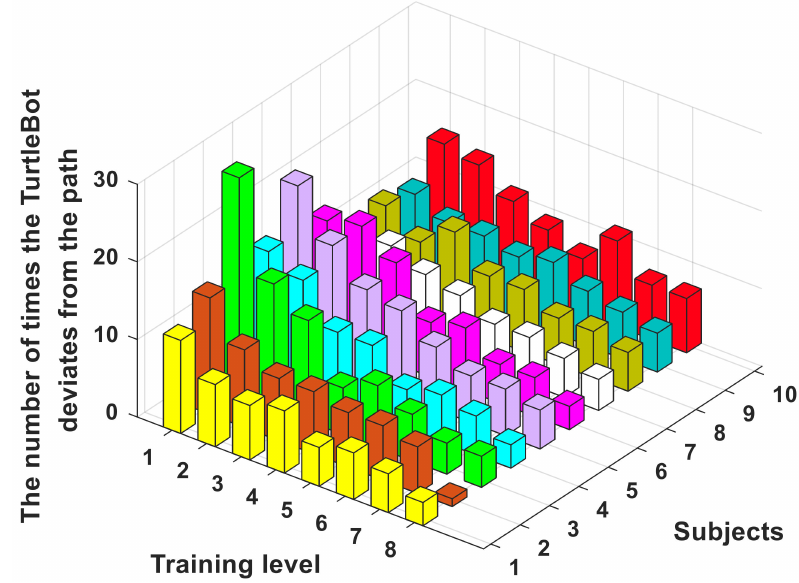
Figure 11. The number of times the TurtleBot deviates from the